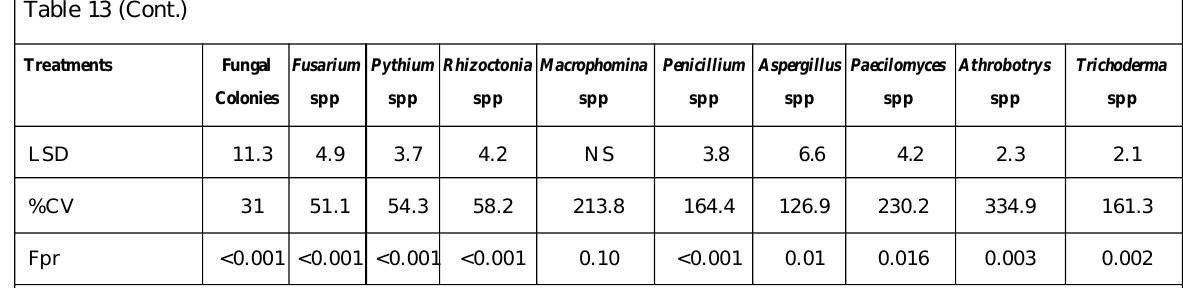
Note: Means with same letter(s) within the same column are not significantly different at p  0.05. LSD: Least significant difference at 5% level, CV: Coefficient of variation, and NS- No significant